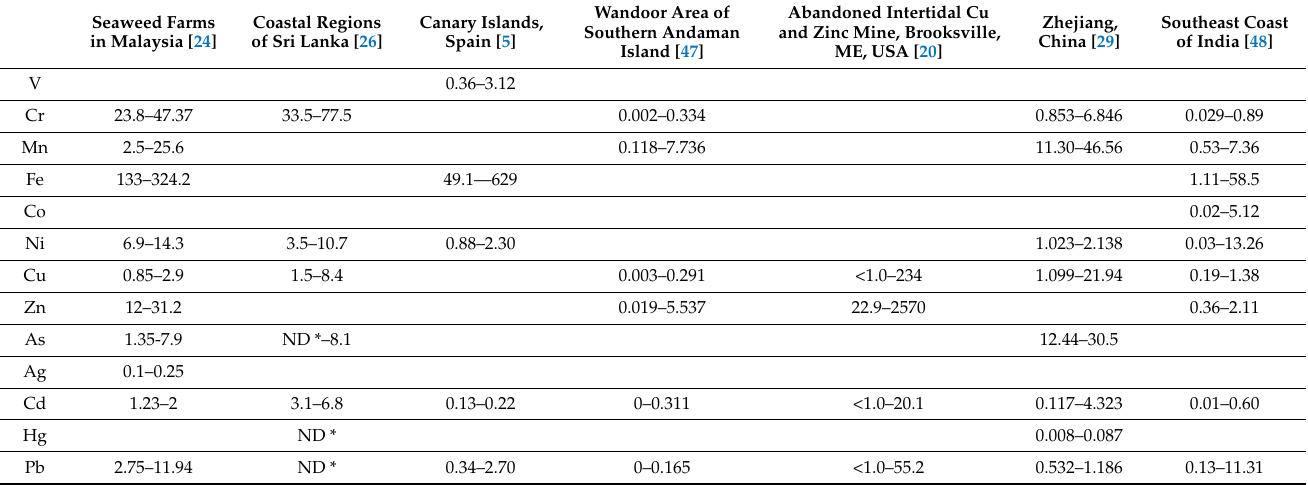
Table 3. Concentrations of the heavy metals in seaweed species at different geographical locations measured by ICP-OES. All values are in µ g/g dry weight. The following data show the range of minimum and maximum values where